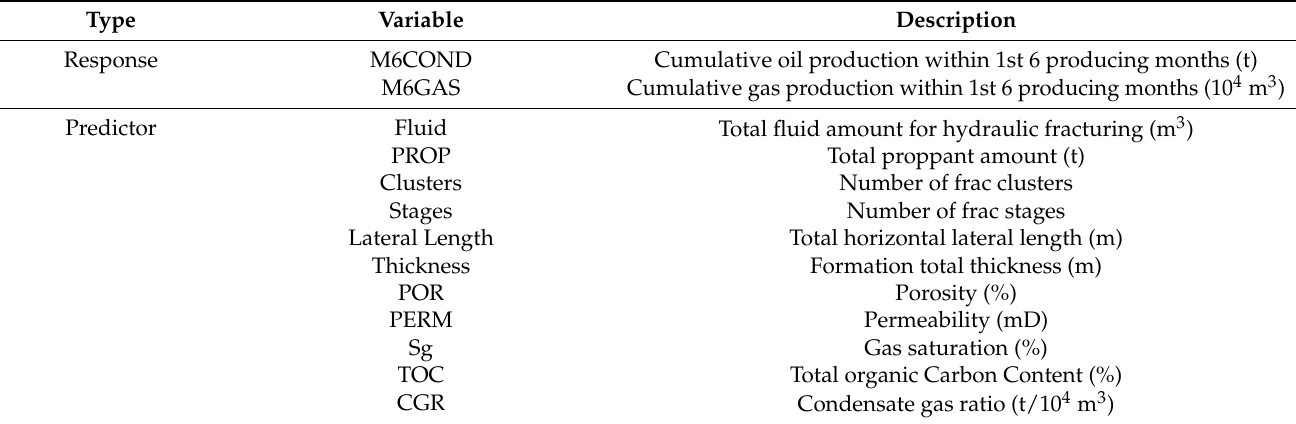
Table 2. List of variables in the study area.